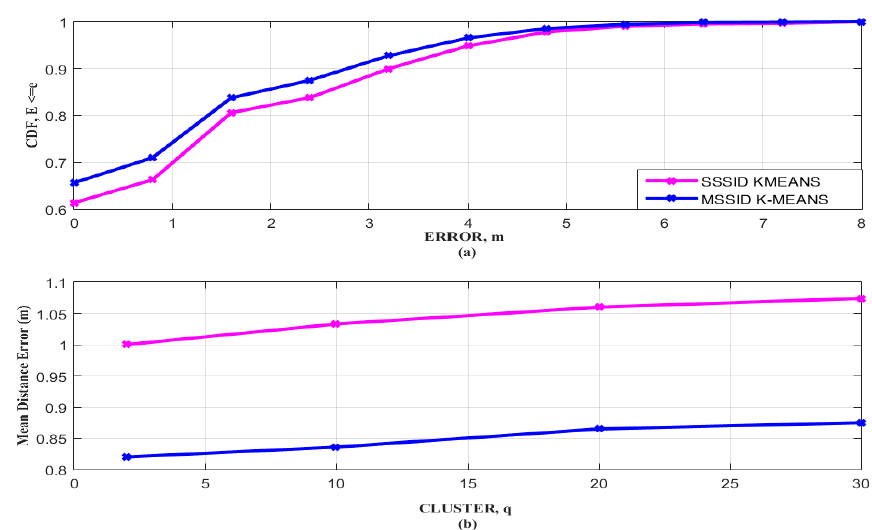
Figure 11. K-means clustering. ( a ) Cumulative Distribution Function (CDF) of Error; ( b ) mean error versus number of clusters.